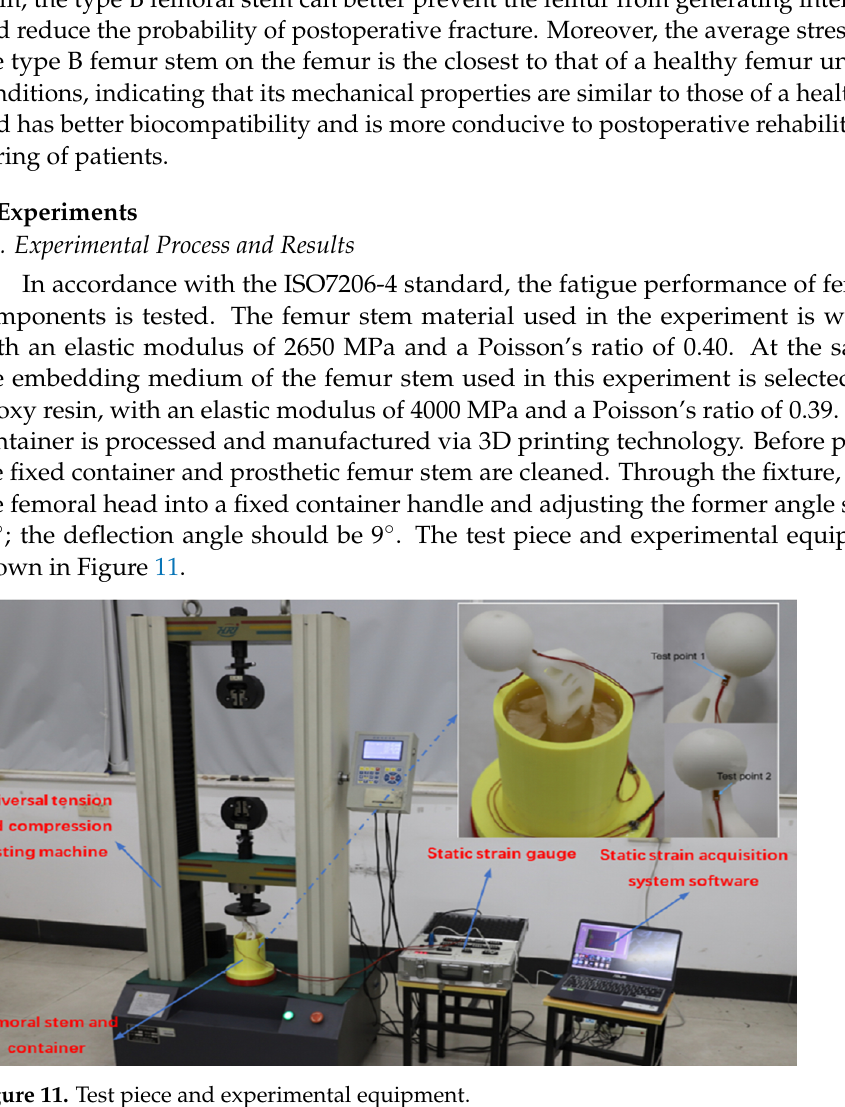
Figure 11. Test piece and experimental